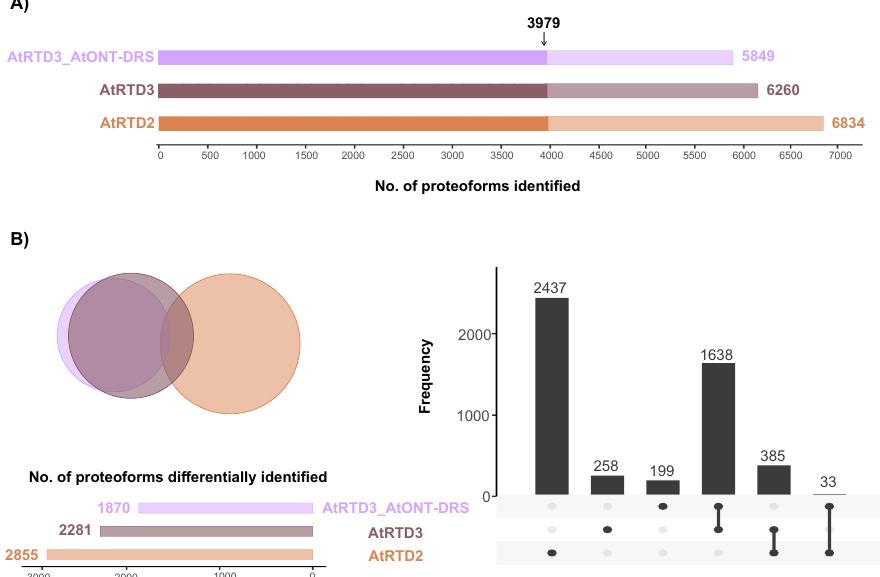
Figure 3. Proteoform identification in a MS proteomics dataset corresponding to Arabidopsis senes- cent leaves. ( A ) Total number of proteoforms unambiguously identified with each database. The arrow marks the proteoforms that were identified by the three databases. ( B ) Venn diagram and UpSet plot showing the overlap between the proteoforms identified with each database, excluding the 3979 identified by the three of